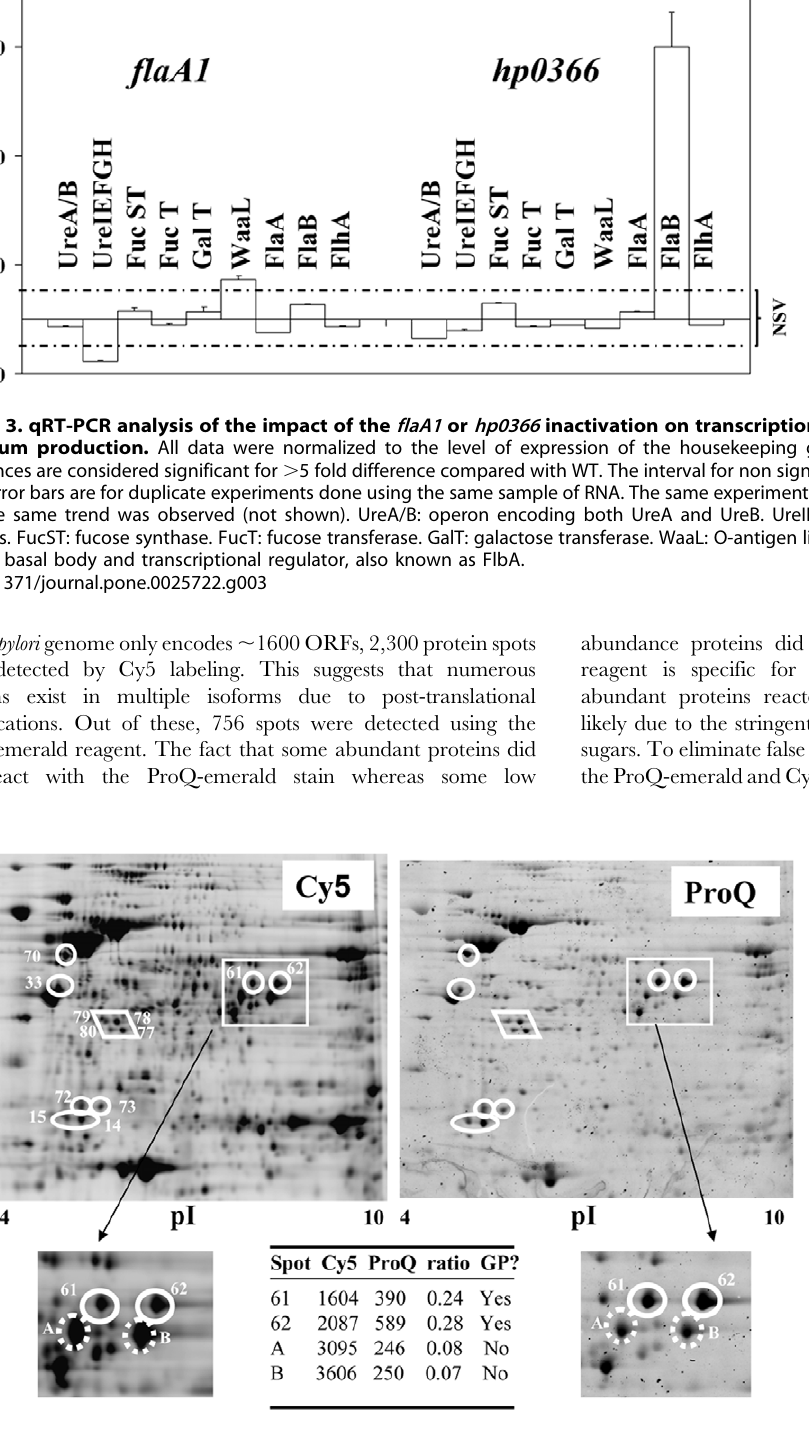
Figure 4. 2D gel electrophoresis analysis of H.pylori glycoproteins using Cy5 labeling of total proteins and ProQ-emerald labeling of glycoproteins. The proteins from WT H. pylori were stained with Cy5 and were resolved by 2D gel electrophoresis. Glycoproteins were stained with ProQ-emerald. Abundant proteins gave a high background reactivity by ProQ-emerald labeling (ex: UreB). To eliminate false positive proteins, the ratio of the ProQ-emerald and Cy5 signals was calculated and only proteins that showed a high ratio were considered GP candidates. The ratios calculated are indicated for a few spots shown as an example in the zoomed figures. Spots A and B are provided as examples of non glycosylated proteins. Signals for Cy5 and ProQ-emerald are in arbitrary units. Contributions from the gel background have already been subtracted. Note that the analysis was limited to a subset of 100 proteins that were present in sufficient amounts to allow their identification by MS ultimately. The 12 spots highlighted on the figure (in circles and diamond) are the ones with the highest ratios in this subset and represent GPs. Additional GPs may be present.